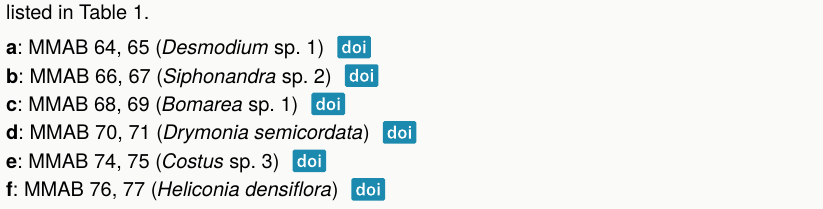
Diversity of putatively bird pollinated plants of the Manú Gradient. MMAB collection numbers listed in Table